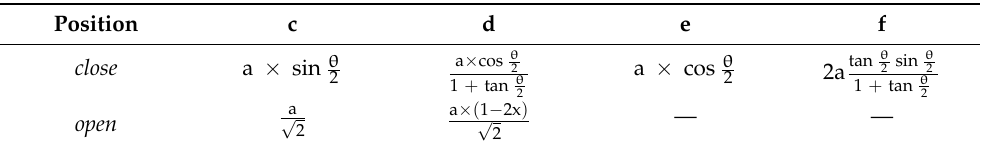
Table 1. Geometric relationships needed to calculate the size of the structure in the closed position and in the open position (see Figure 5).